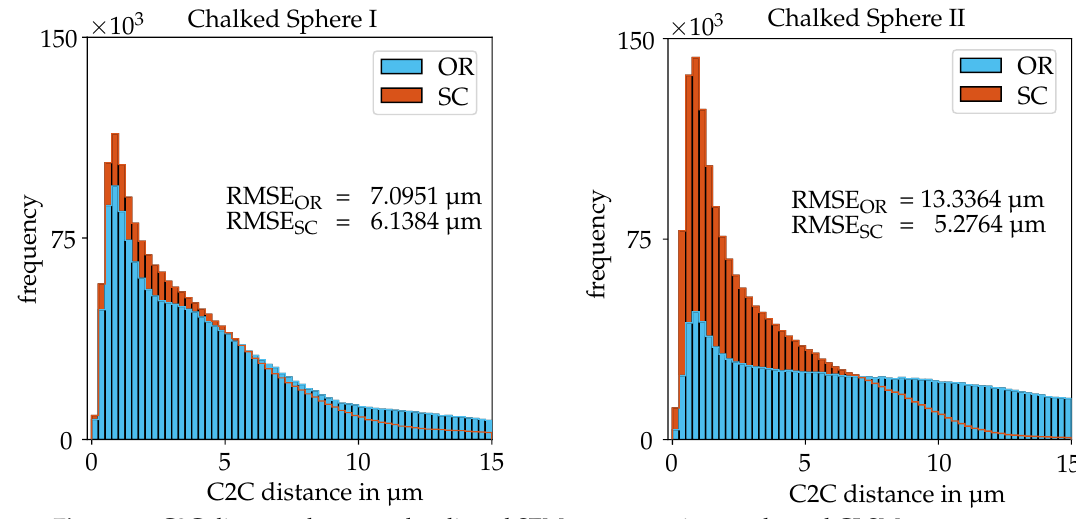
Figure 15. C2C distances between the aligned SEM reconstruction results and CLSM measurements for the respective factorization method regarding the image sequences of the Chalked Sphere (1855408